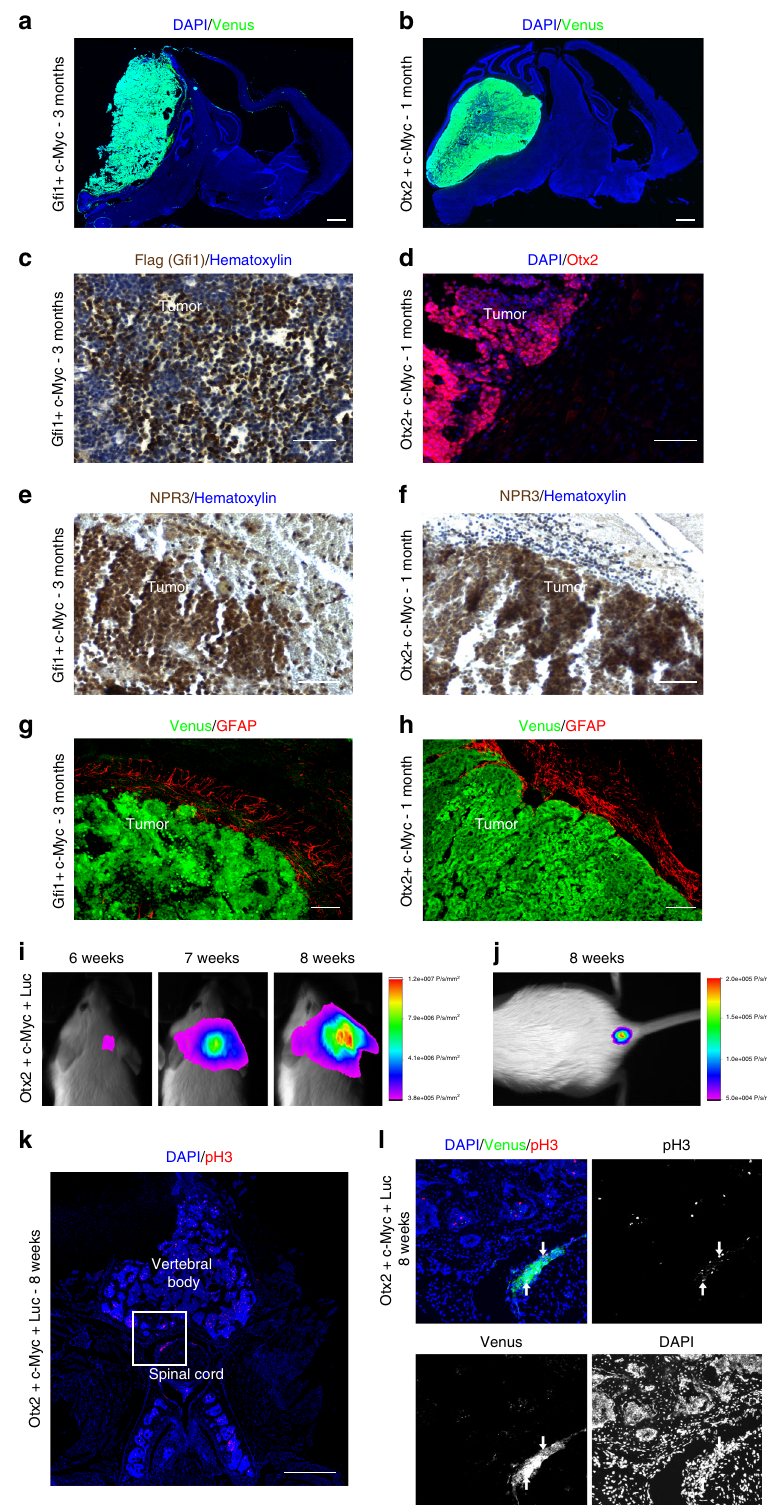
organoids, con fi rming our fi ndings in mice (Supplementary Fig. 5K). To test whether organoid-derived model of human Group 3 MB is able to induce cancer in vivo, we injected them in Foxn1 nu (nude) mice (Fig. 5a). We observed the formation of